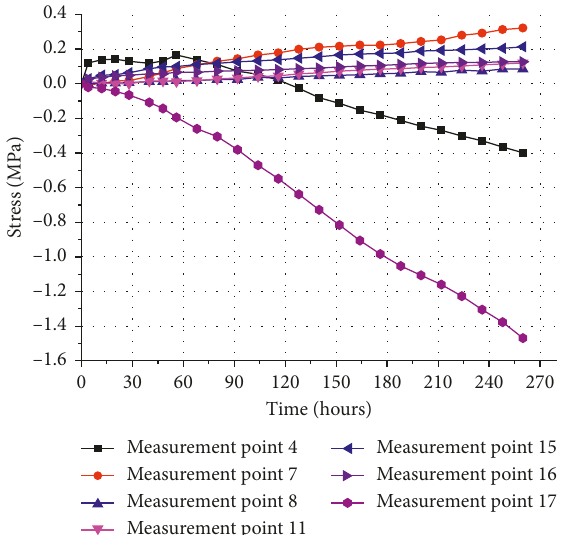
Figure 8: Time history curves of surrounding rock stresses on the left tunnel